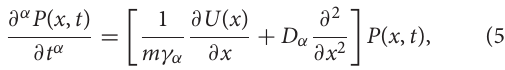
1.5 and T 0 0.5 for the initial temperatures. In both cases we used T = =